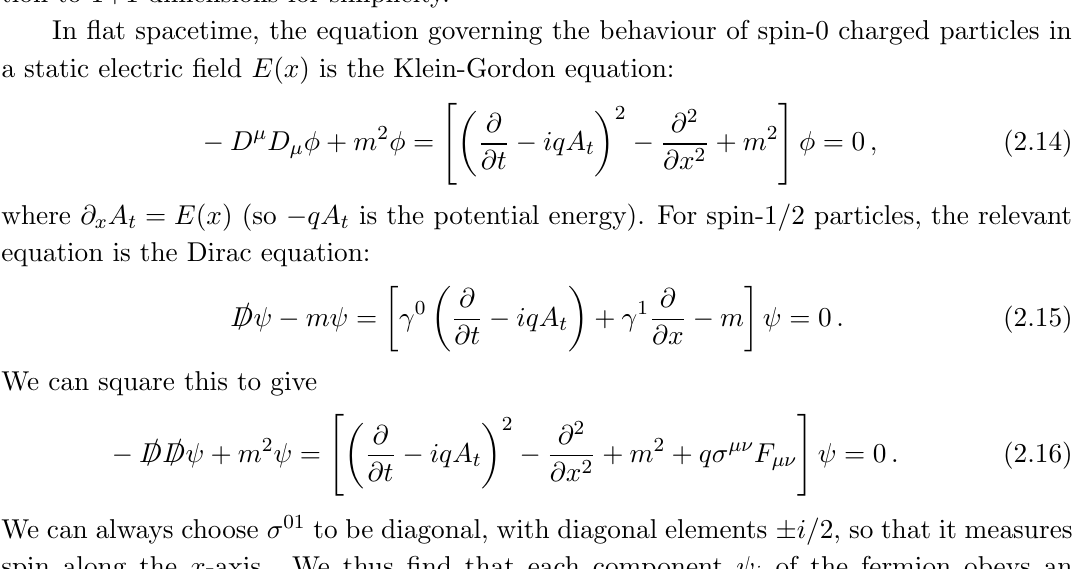
JHEP03(2020)038